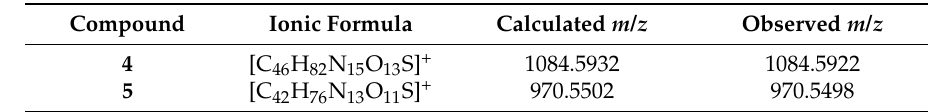
Scheme 2. The solid phase synthesis of compound 5 . Table 1. HRMS analysis of compounds 4 and 5 a .